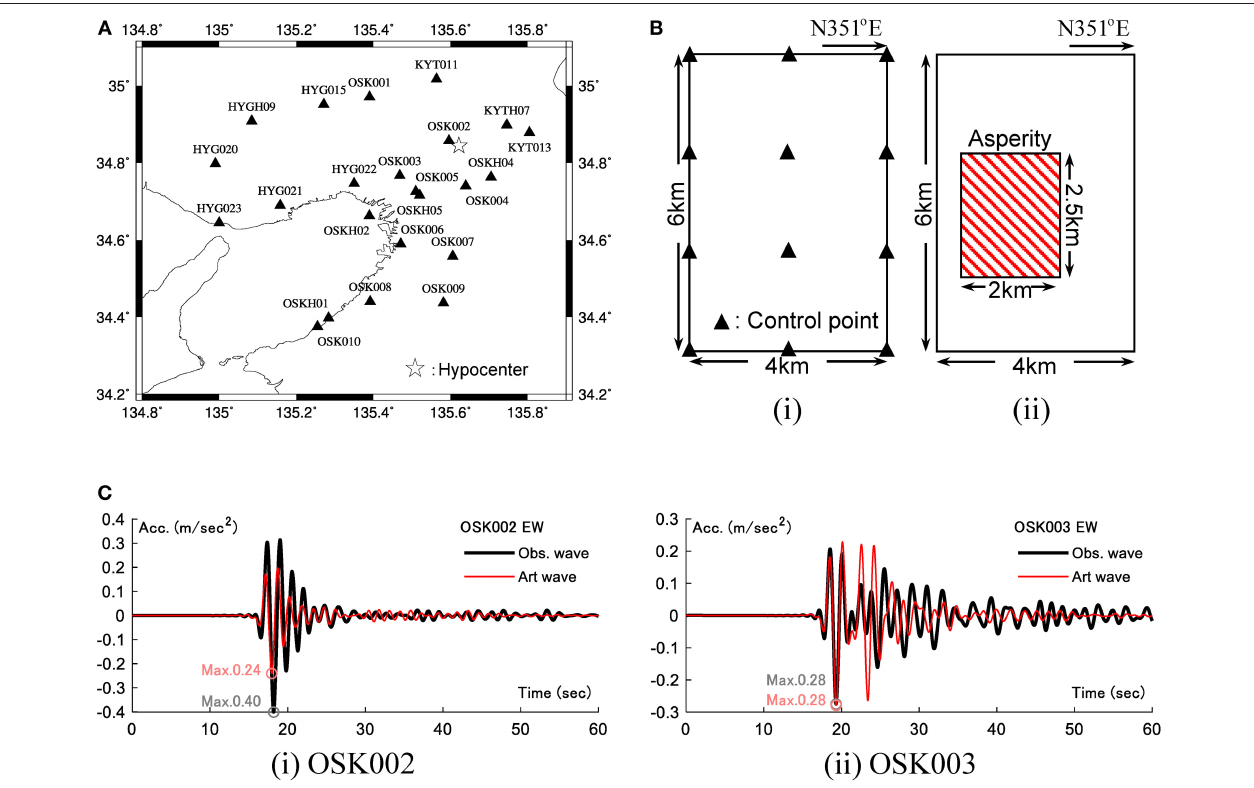
FIGURE 12 | Verification of FDM using 2018 Osaka North earthquake. (A) Source, stations, and region of finite-difference model (GMT). (B) Fault model of 2018 Osaka North earthquake [(i) Control point for critical model, (ii) Recipe model]. (C) Comparison between observation wave and art wave by recipe model.